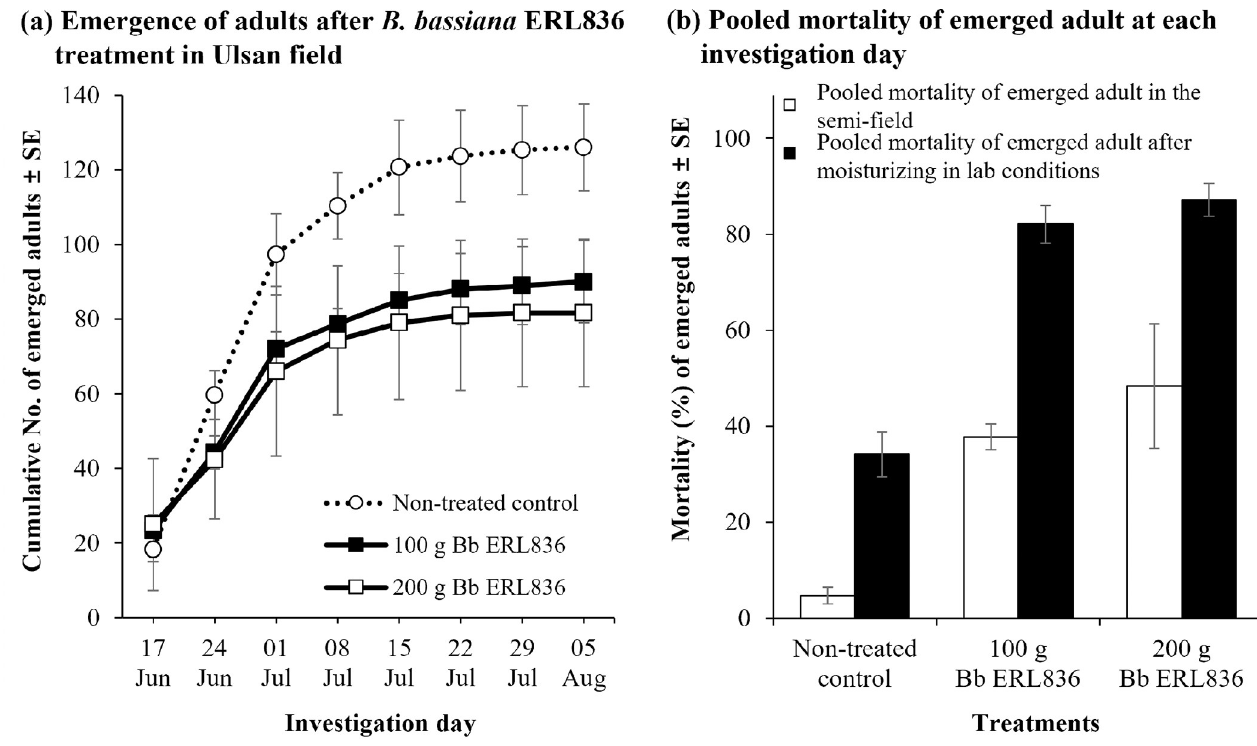
Fig 6. Control efficacy of B . bassiana ERL836 against M . alternatus by fungal powder formulation pre–treatment of naturally larvae–infested pine logs in forest field conditions. The surfaces of pine logs naturally infested with M . alternatus larvae were powdered with B . bassiana ERL836 fungal powder formulation, and then the logs were piled and sealed with a film. At weekly intervals, the number of emerged and dead M . alternatus adults was counted. The error bars represent the standard error of the mean of the number of emerged adults (a). In the field, mortality of adults at each investigation time was pooled, and additionally to see the possibility of infection in the alive adults, alive adults were moved to a lab and kept in moisturized Petri–dishes for 14 days and mortality was checked and pooled. The error bars represent the standard error of the mean of mortality (b).